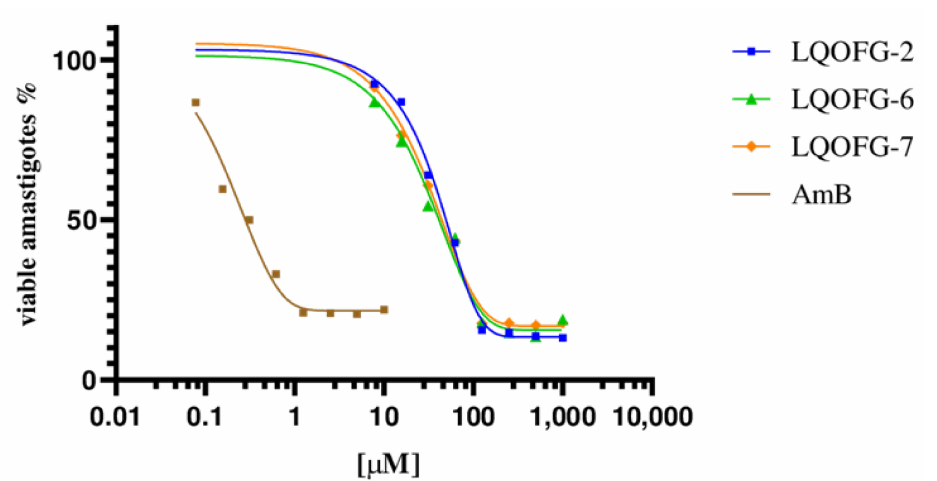
Figure 2. Cell viability % of axenic amastigotes treated with LQOFG-2, LQOFG-6, LQOFG-7, and Amphotericin